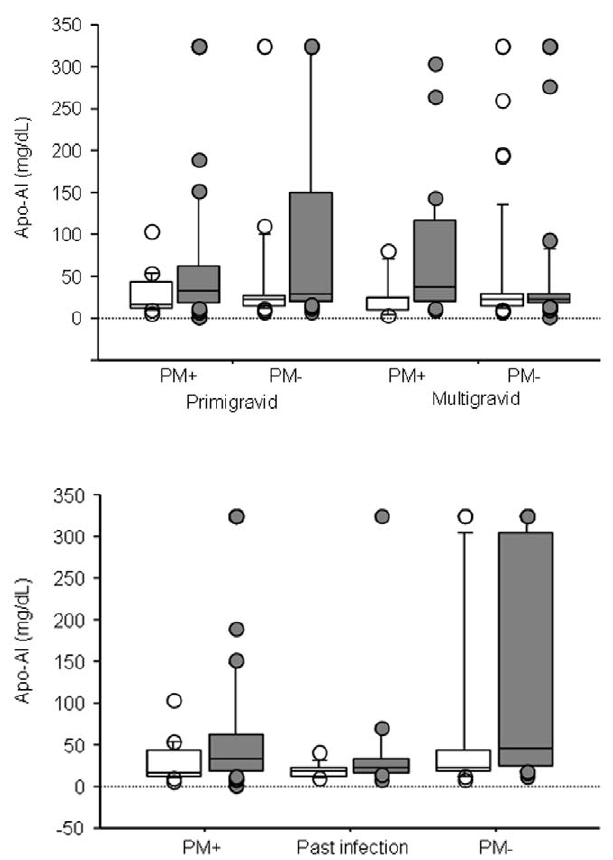
Figure 2. Comparison of peripheral plasma levels of Apo-A1 between malaria-infected and uninfected women with and without severe anemia. (A) Apo-AI levels in severely anemic (open boxes) and non-anemic (gray boxes) women stratified by gravidity and malaria infection status. Number of samples tested (severely anemic, non- anemic) and the significance of differences between anemic and non- anemic women (p value analyzed by Mann-Whitney U test): primigravid, PM + (17, 58; p =0.016); primigravid, PM- (27, 48; p =0.015); multigravid, PM + (7, 26; p =0.11); multigravid, PM- (54, 58; p =0.6). (B) Apo-AI levels in severely anemic (open boxes) and non-anemic (gray boxes) primigravid women stratified by 3 stages of infection: active infection (PM + ), past infection, and no infection (PM-). Number of samples tested (severely anemic, non-anemic) and the significance of differences between anemic and non-anemic primigravid women (p value analyzed by Mann-Whitney U test): PM + (17, 58; p =0.016); past infection (11, 17; p =0.18); PM- (16, 31; p =0.06). The box plots include the median (middle line), interquartile ranges (box), and 10-90 th percentiles (whiskers).